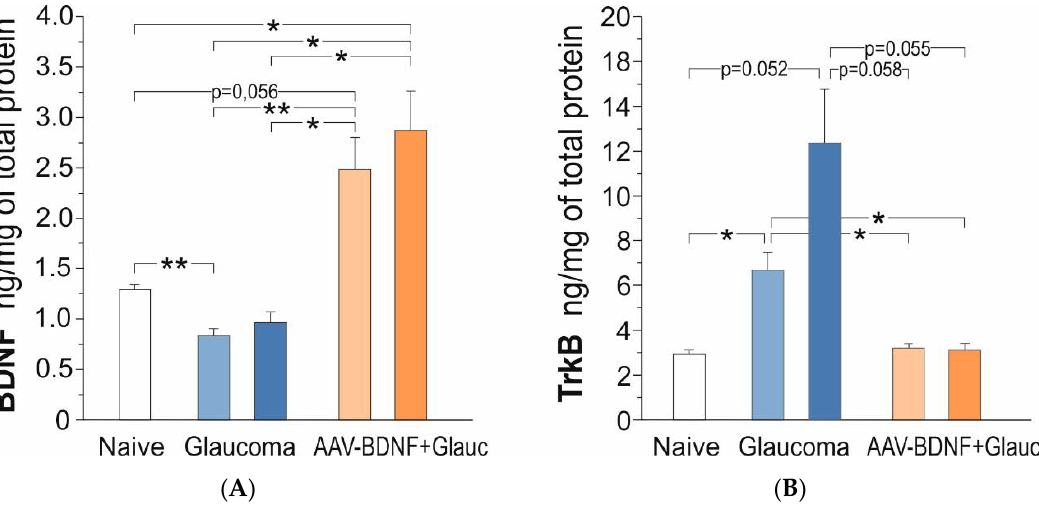
Figure 4. BDNF ( A ) and TrkB ( B ) protein concentration in the retina of the rats: intact control (Naive; white), with uniocular, transient glaucoma (Glaucoma; blue) and injected intravitreal with AAV-BDNF three weeks prior to glaucoma induction (AAV-BDNF + Glauc.; orange). Light color represents the Left eye, dark color represents the Right eye with induced glaucoma. Data are shown as mean ± SD from 9 (intact control group), 6 (glaucoma group) and 6 (AAV2-BDNF + glaucoma group) rats. ** p < 0.01, * p < 0.05.